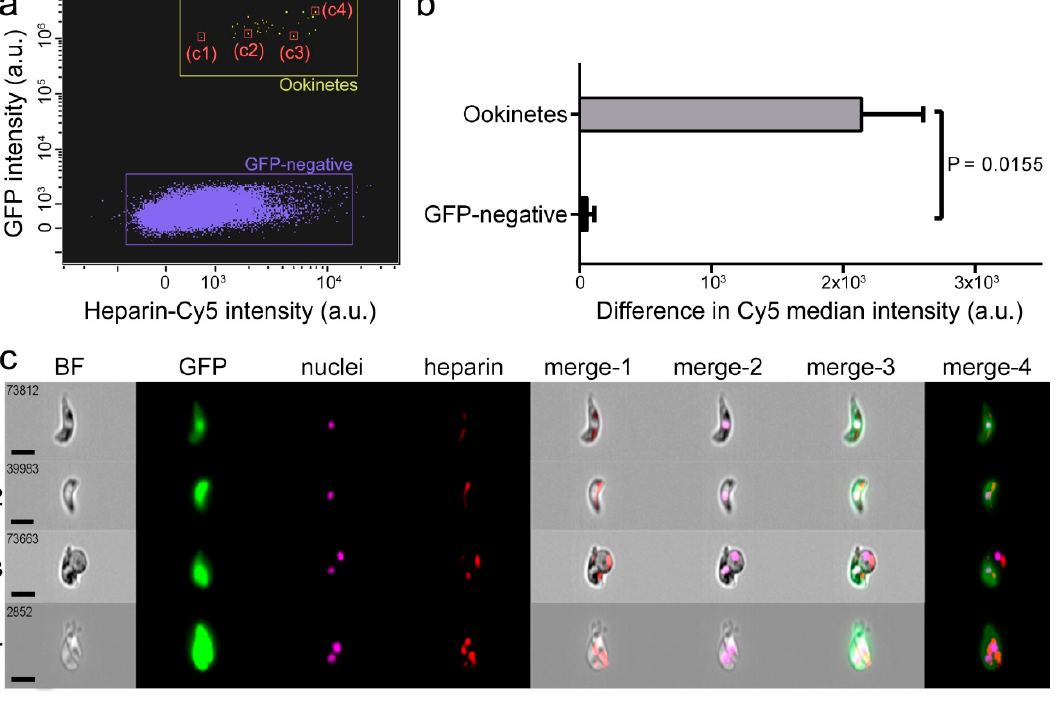
Figure 1. Heparin-Cy5 binding to ookinetes. ( a ) Flow cytometry plot showing heparin-Cy5 signal in green fluorescent protein (GFP)-expressing P. berghei ookinetes. GFP-negative events correspond mostly to red blood cells (see Figure S1 for gating strategy). c1 to c4 refer to the individual events reported in panel c . ( b ) Di ff erence in Cy5 median intensity between GFP-expressing ookinetes and GFP-negative cells. ( c ) Fluorescence images of the flow cytometry events indicated in panel a . The merges of the bright field (BF) image with the fluorescence of heparin, nuclei, GFP, and all three of them, are indicated as merge-1 to merge-4, respectively. Size bars represent 7 µ m.